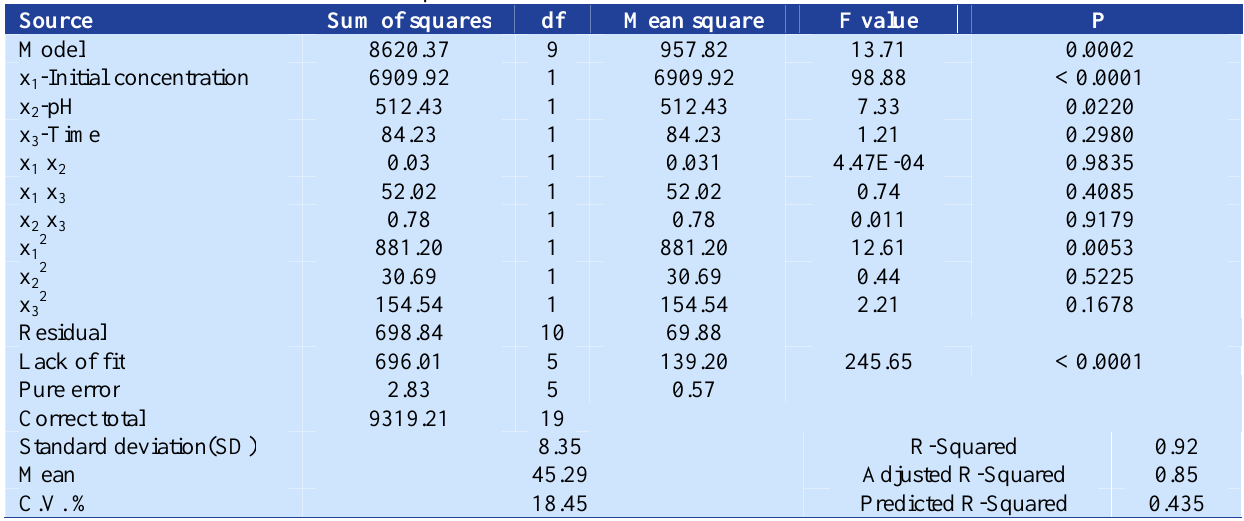
Table 3 . ANOVA for color removal response surface